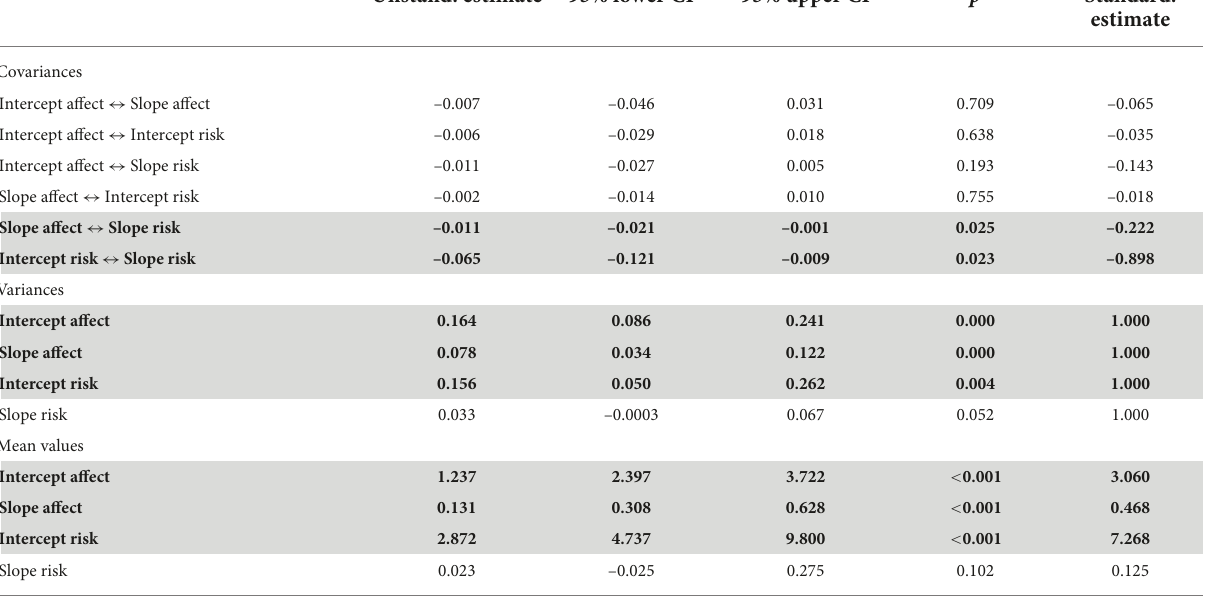
TABLE 2 Parameter estimates from unconditional parallel process model.